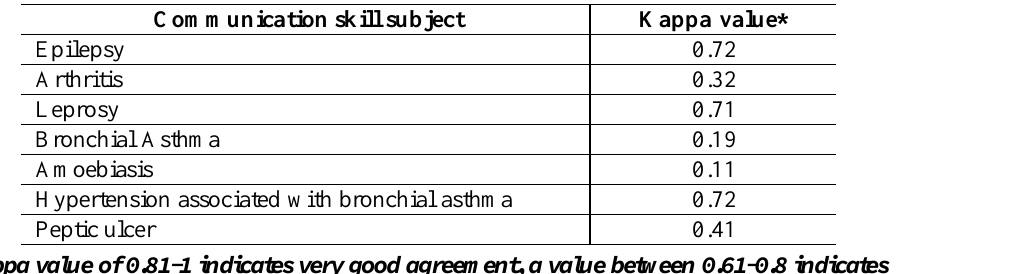
* A kappa value of 0.81-1 indicates very good agreement, a value between 0.61-0.8 indicates substantial agreement and 0.41-0.6 indicates moderate agreement. Values between 0.21-0.4 indicate fair agreement, values less than 0.2 indicates poor agreement. Table III : Agreement between the two observers regarding the scoring of 'non-pharmacological' measures